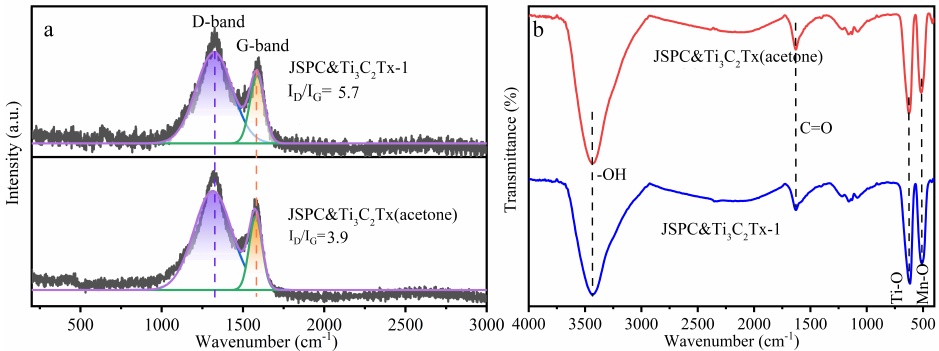
Figure 3. Raman ( a ) and FTIR ( b ) spectrum of porous carbon